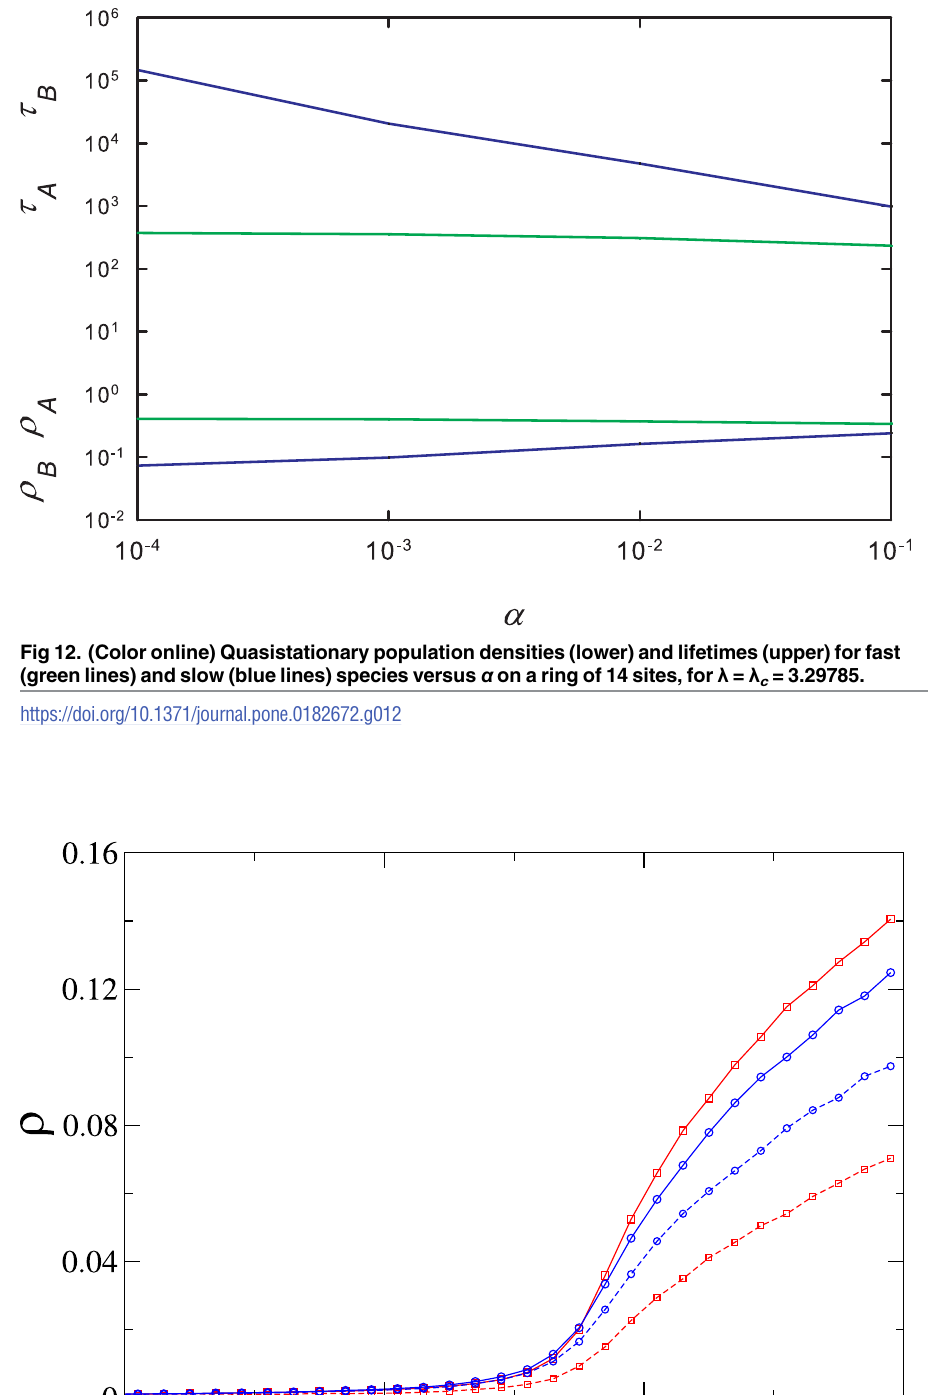
PLOS ONE | https://doi.org/10.1371/journal.pone.0182672 August 14,